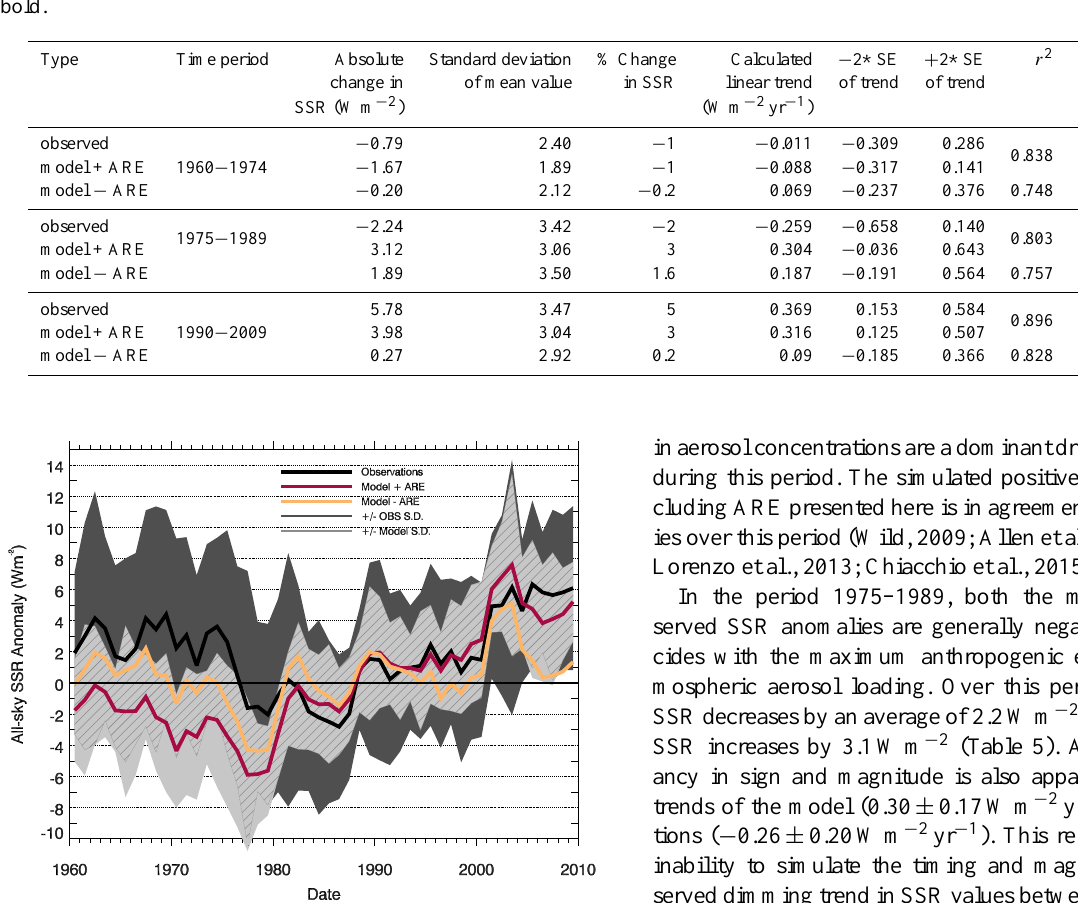
Figure 13. Observed (black line) and simulated (red line) European annual mean all-sky SSR anomalies (Wm − 2 ) relative to a 1980– 2000 average. Simulated all-sky SSR not including aerosol radiative effects (ARE) is also shown (orange line). Values are calculated as the average across all measurement locations within Europe (see Fig. 1). The standard deviation of the annual mean for each year is shown by the shaded areas of dark grey for the observations and light grey for the model with the hatching representing where the areas